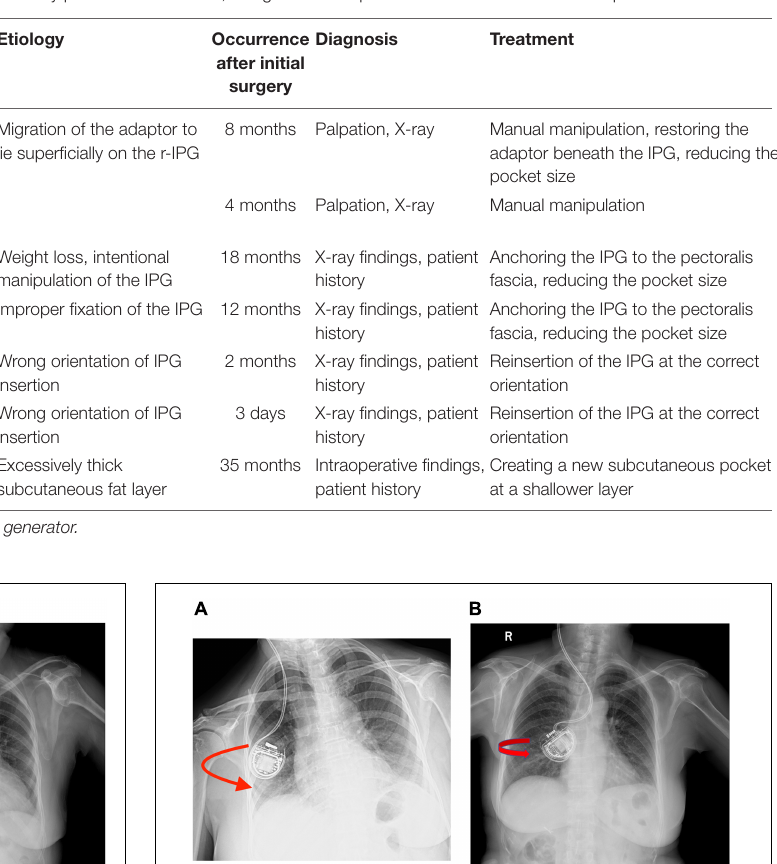
TABLE 1 | Clinical characteristics of the recharging difficulty presented by patients in this article, along with those presented in the literature for comparison.